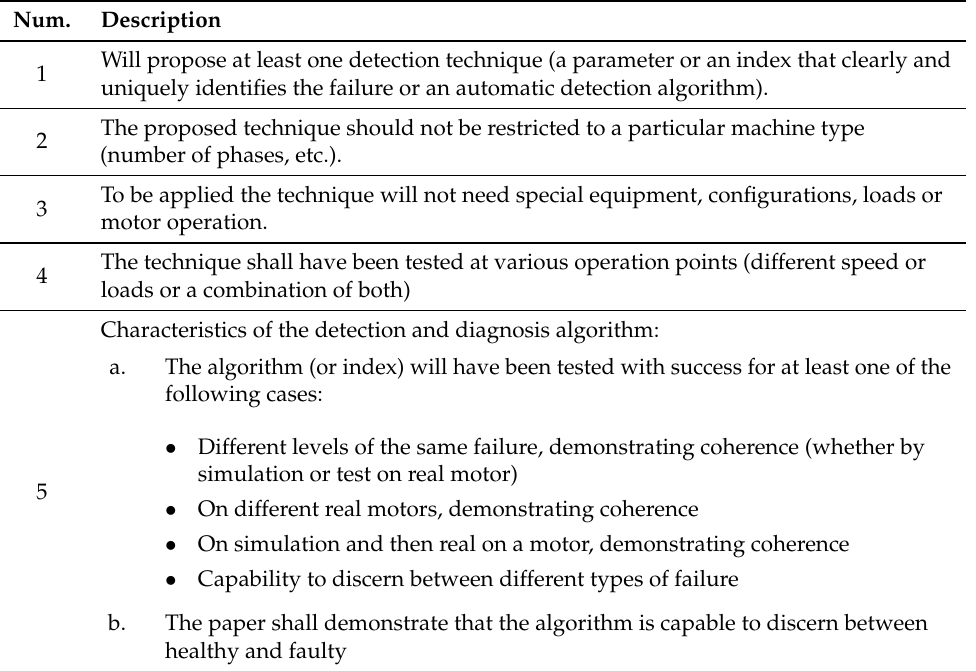
Table 1. Inclusion Criteria.